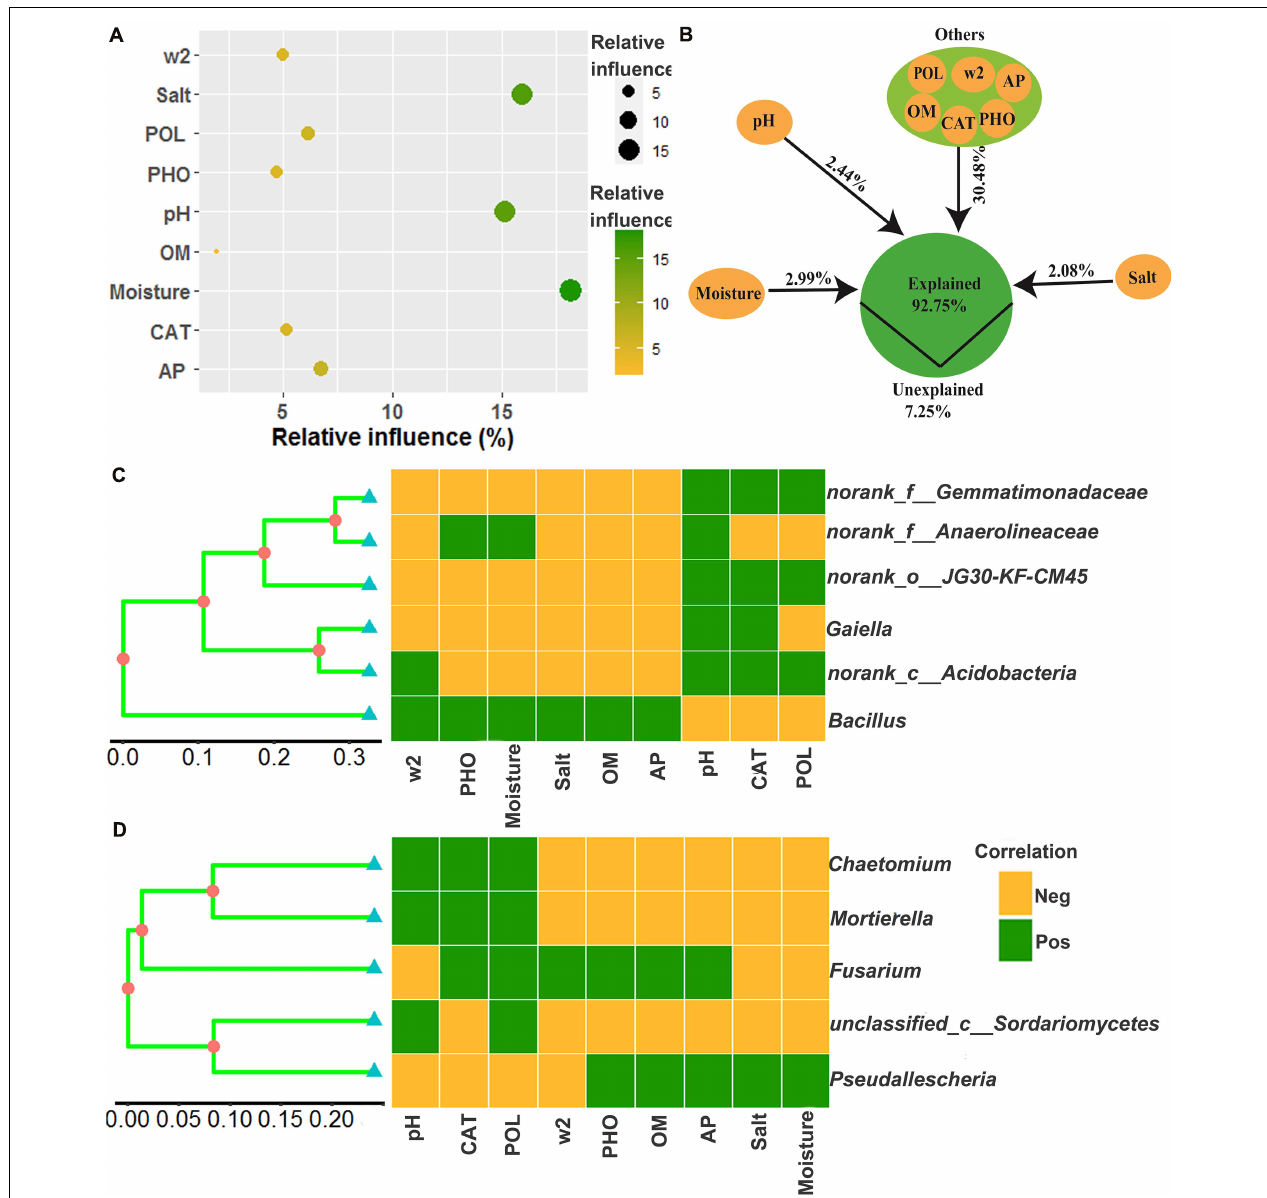
FIGURE 7 | The correlation between the environmental variables and the dominant microbial community. (A) the relative influence of the environmental variables on the dominant microbial community; (B) the contribution of the environmental variables to the assembly process of the dominant microbial community; (C,D) , Mantel test based on the Bray-Curtis distance. W2 represents > 2 mm water-stable aggregates, and CAT, POL, and PHO are catalase, polyphenol oxidase and alkaline phosphatase activities,